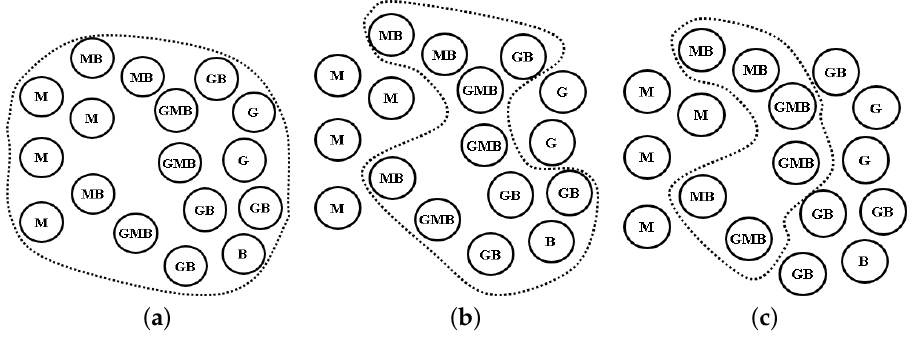
Figure 1. Examples of traditional and deep density-based clustering of the geo-tagged photos (M = Moose, B = Bison, and G = Grizzly Bear in Yellowstone National Park). ( a ) only spatial predicate; ( b ) a spatial predicate and a deep predicate ‘Bison’; ( c ) a spatial predicate and a deep predicate ‘Bison AND